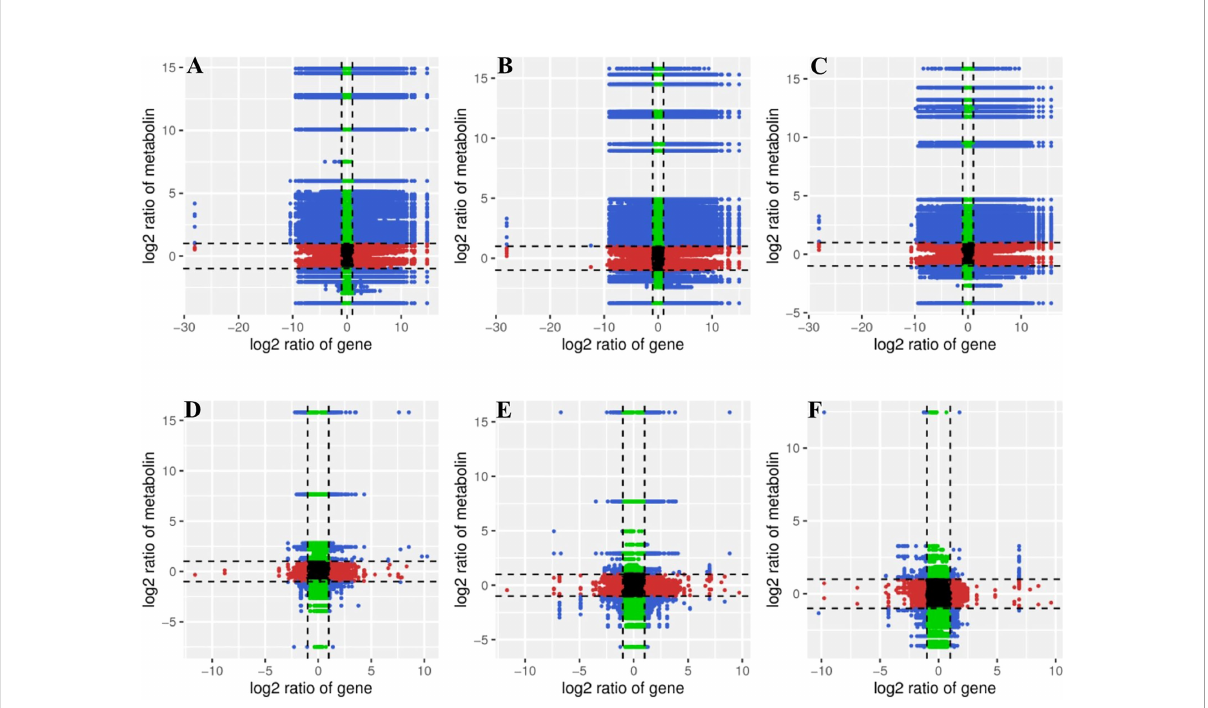
FIGURE 3 Correlation quadrant diagrams representing association of DEGs and DAMs. (A) , CK vs T1; (B) , CK vs T2; (C) , CK vs T3; (D) , T1 vs T2; (E) , T1 vs T3; (F) , T2 vs